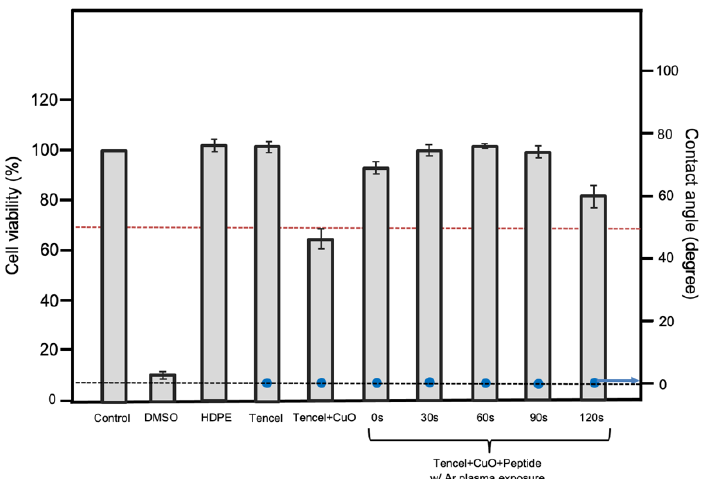
Figure 5. Cytotoxicity (red dashed line indicates 70% viability) and contact angle measurement (black dashed line indicates zero degree) of the Tencel membranes.